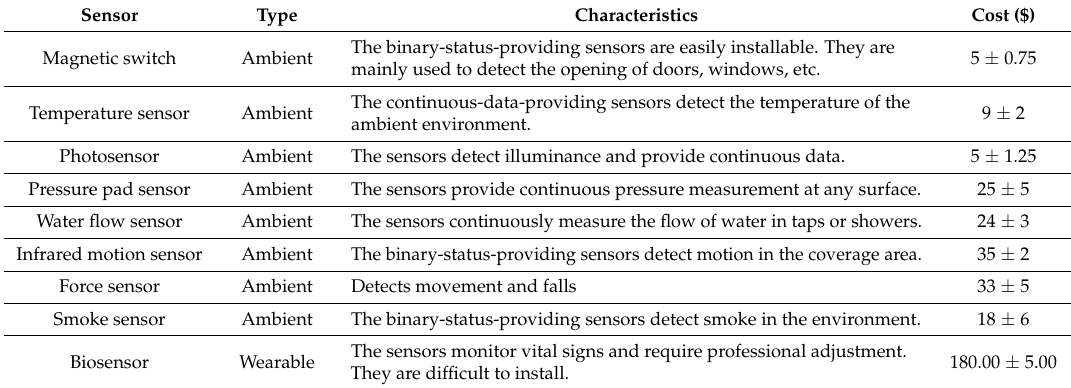
Table 1. Ambient assistive living sensors, their types, characteristics, and costs, from